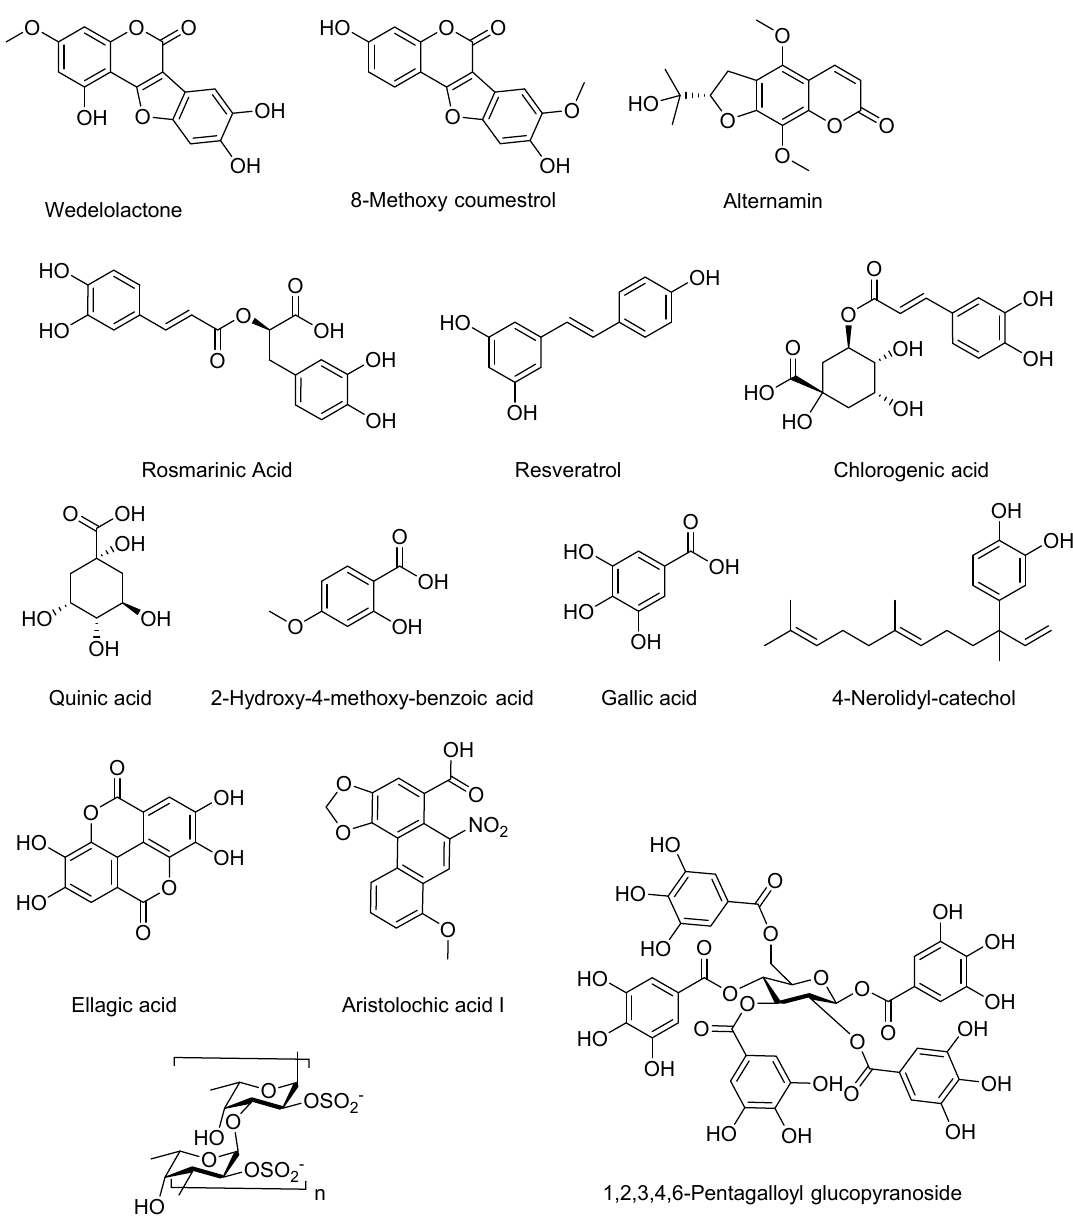
Figure 2 . Selected phenolic compounds and the fucoidan sugar with antivenom activity . Figure 2. Selected phenolic compounds and the fucoidan sugar with antivenom